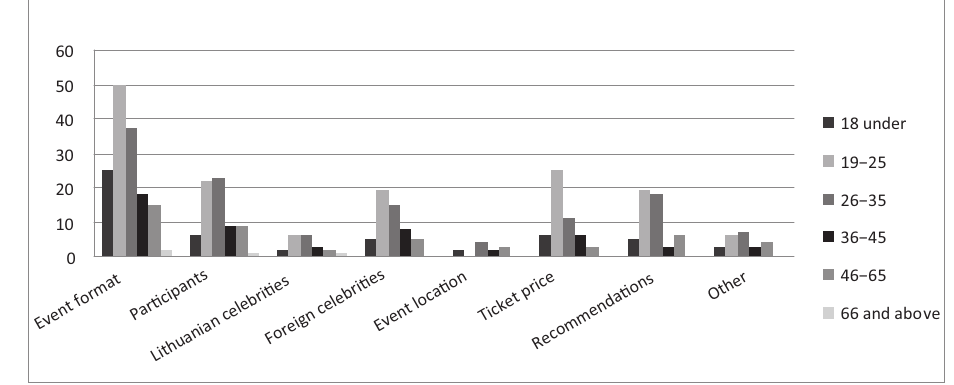
Fig. 4. Correlation between festival selection and age